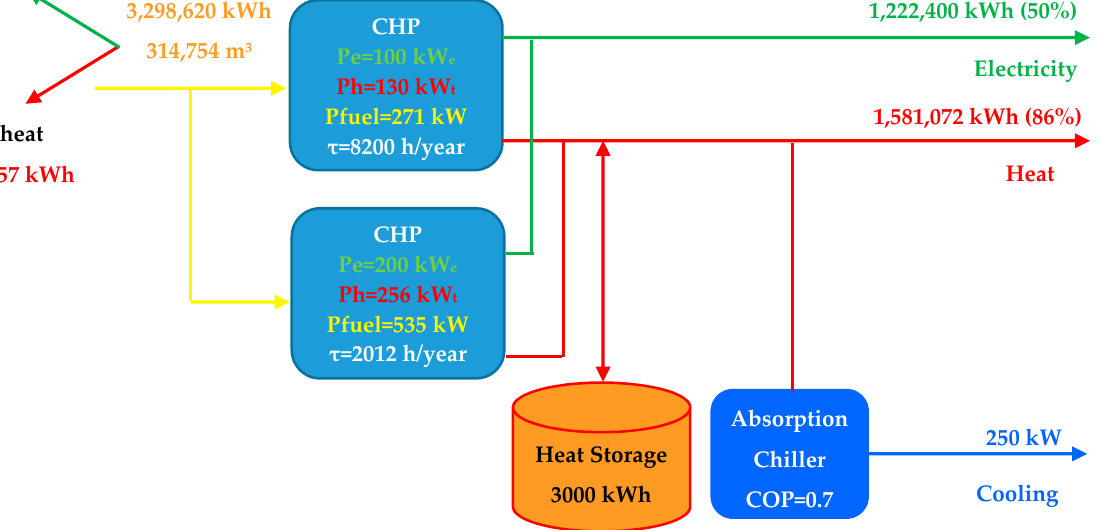
Figure 27. Trigeneration with two different units (1 × 100 kW e , 1 × 200 kW e , 1 × 130 kW t , 1 × 256 kW t ) and heat storage.